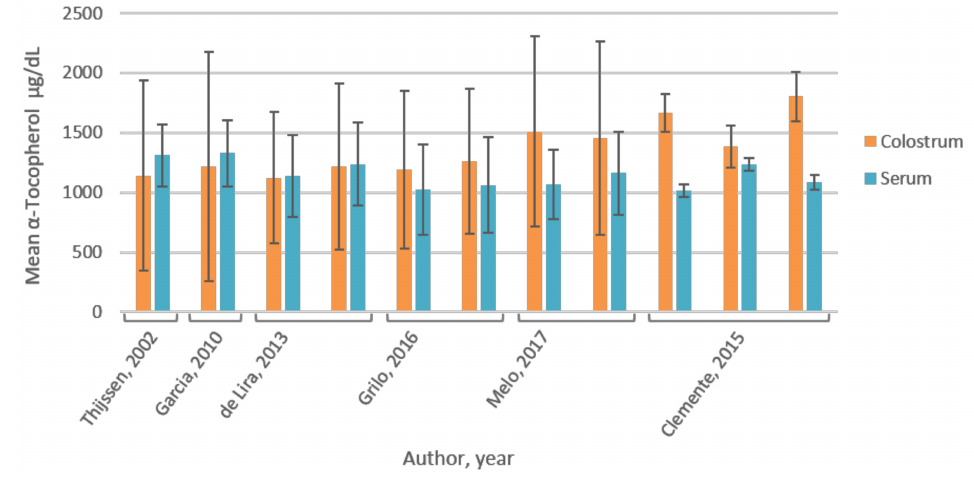
Figure 2. Reported α -tocopherol concentrations in colostrum and serum. Standard deviations for mean α -tocopherol levels in colostrum are major compared to serum in all publications. Mean concentrations of colostrum α -tocopherol are slightly lower than in serum reported by Thijssen and Garcia et al. [40,41]. No statistical significance of this difference was indicated and standard deviations show